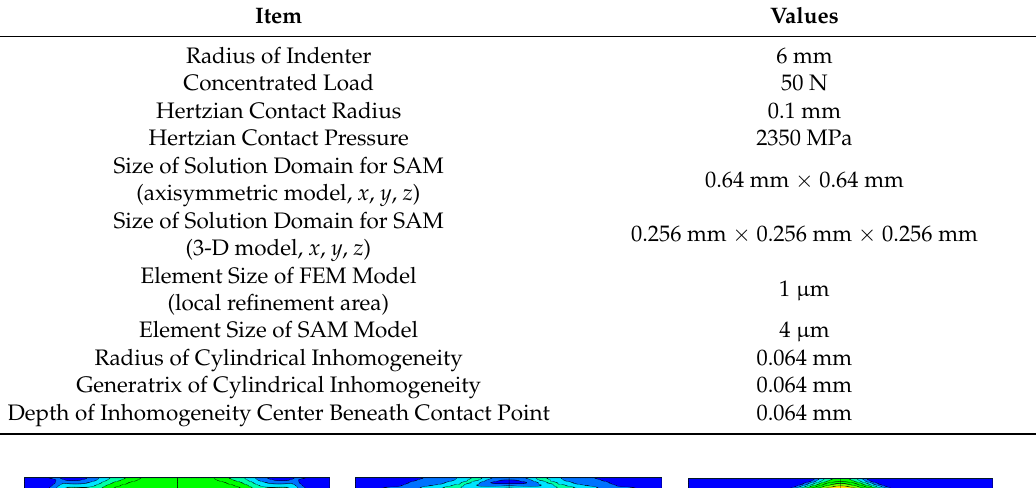
Table 2. Loading Conditions and model parameters.